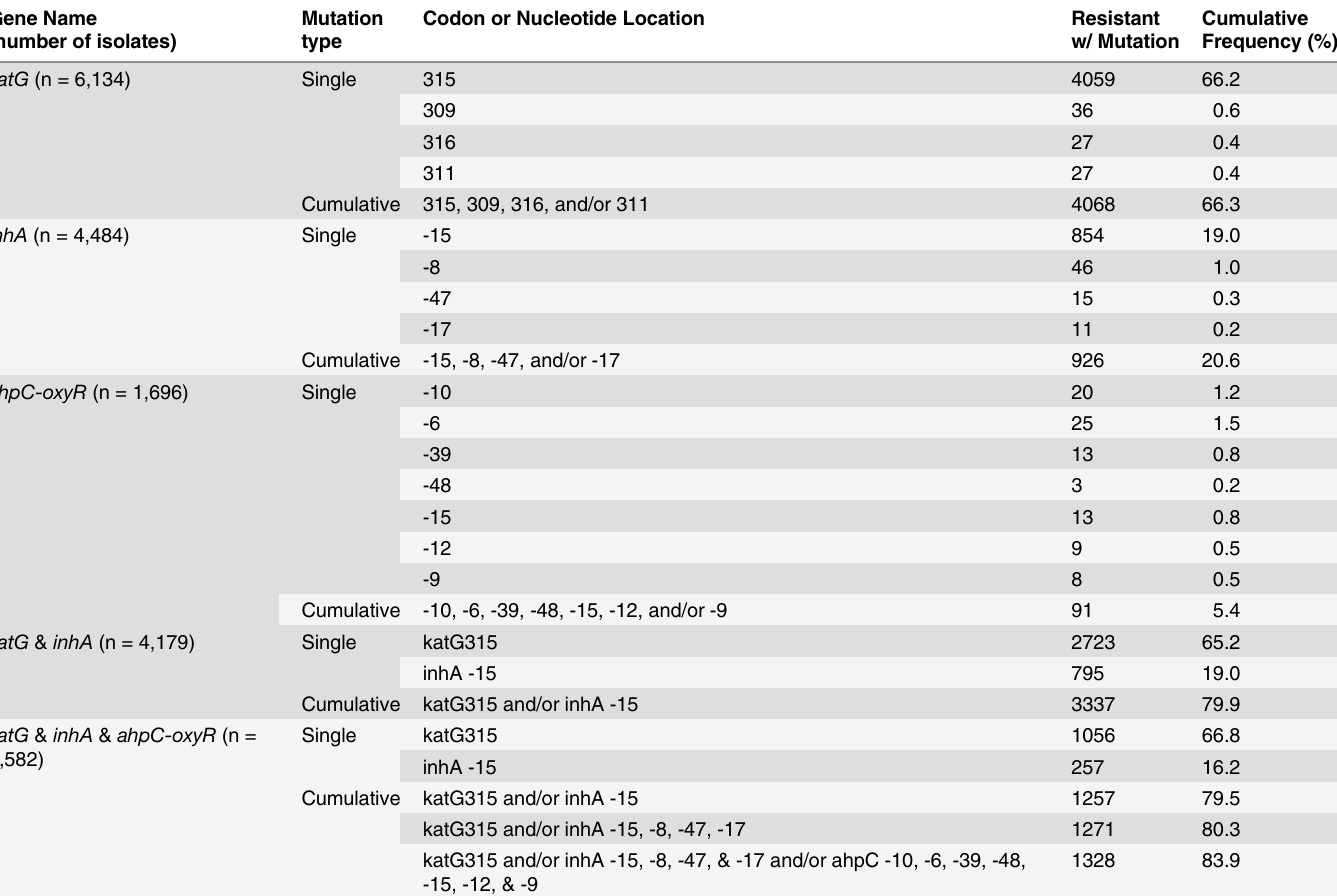
Table 4. Single and cumulative mutation frequencies on katG , inhA , and ahpC-oxyR among data subsets which assessed co-occurring mutations. Gene